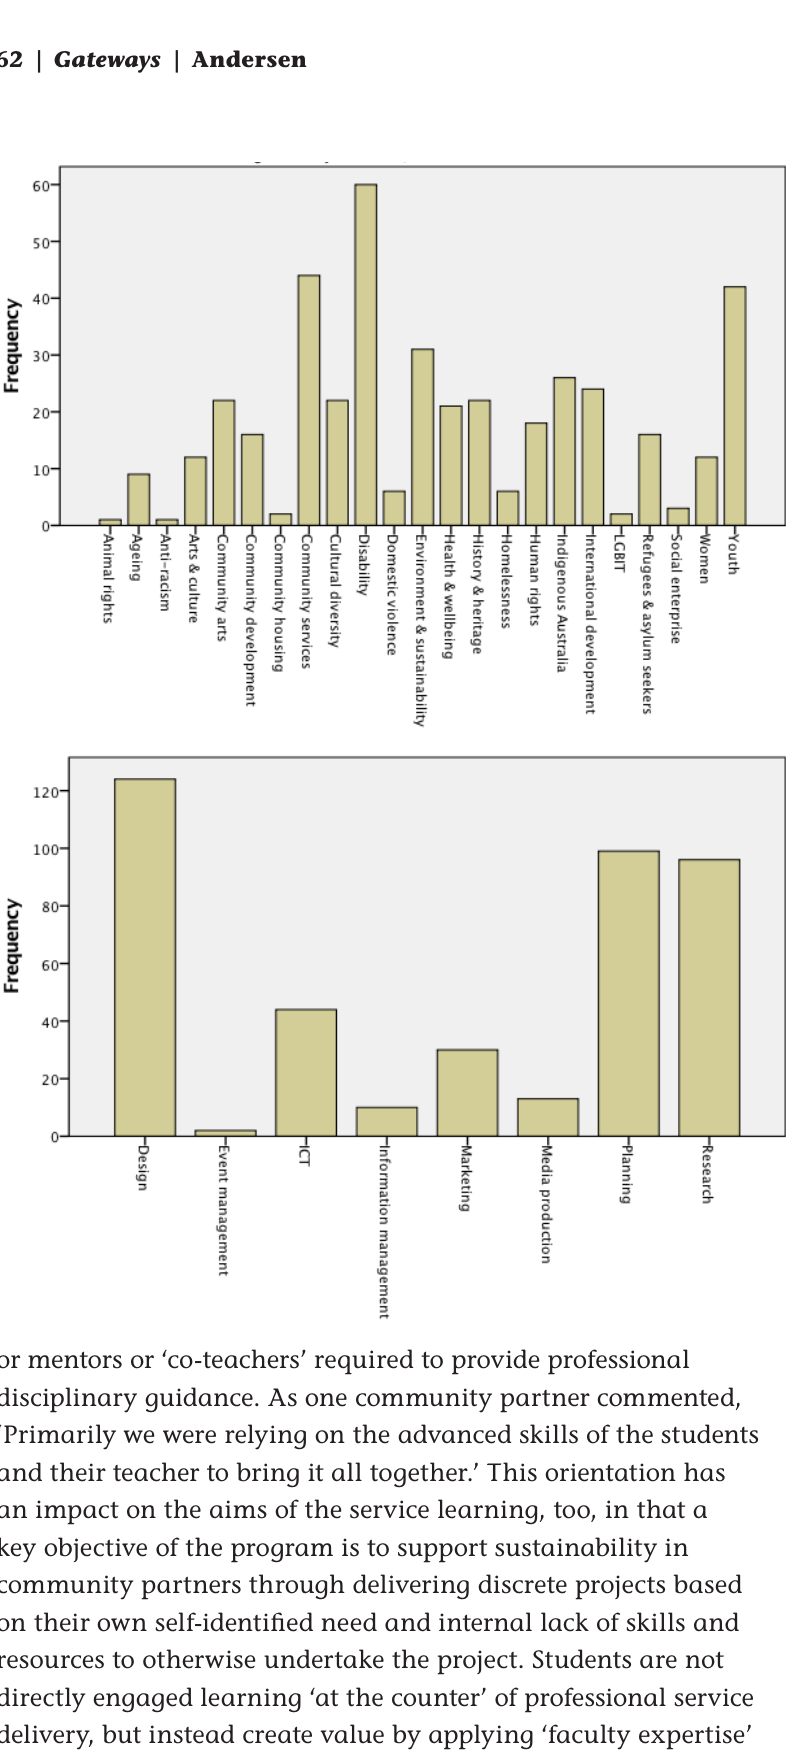
Figure 1: Projects by sector,